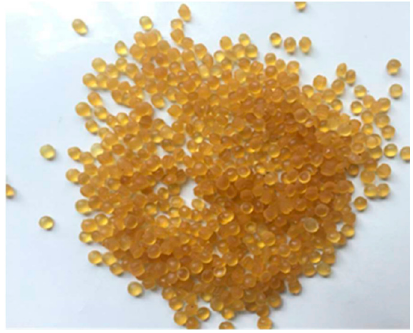
Figure 1. SINOTPS modifier.